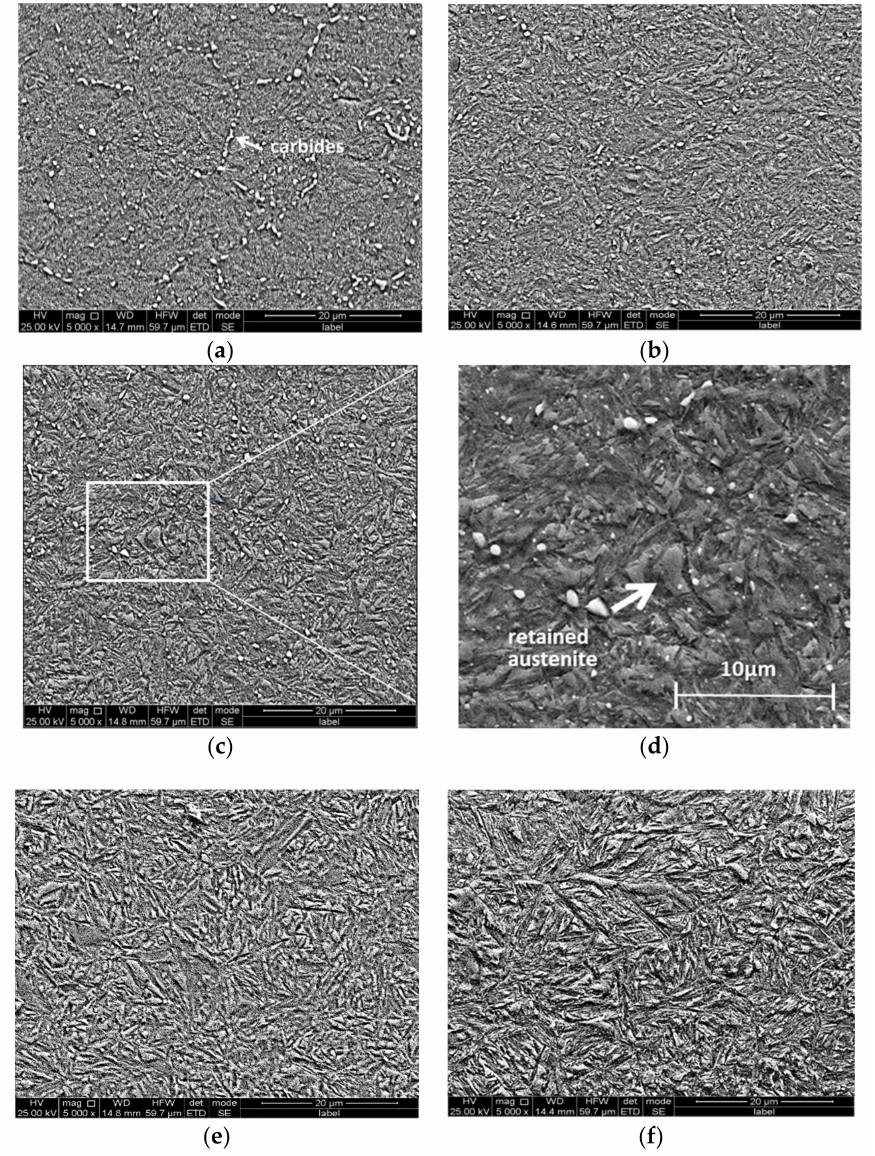
Figure 3. Scanning electron microscope (SEM) micrographs showing the carburized case of the specimens re-austenitized at ( a ) 820 ◦ C, ( b ) 840 ◦ C, ( c ) and ( d ) 860 ◦ C, ( e ) 880 ◦ C, and ( f ) 900 ◦